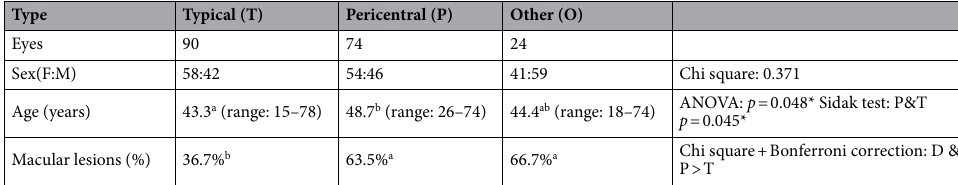
Table 1. Demographic data of electroretinogram (ERG) analysis in different subtypes of RP. F female, M male, ANOVA analysis of variance. a, b Means within a row with different superscripts are different at P < 0.05. * p < 0.05.